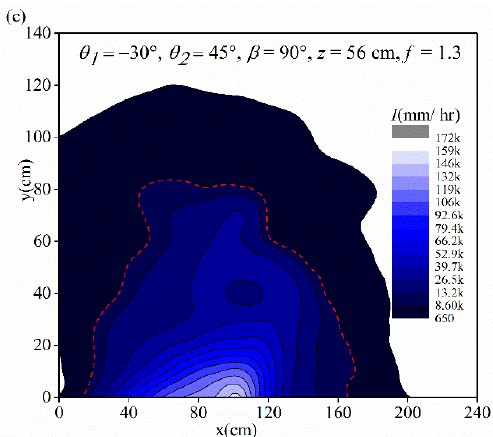
Figure 5. Rainfall intensity distribution at different collision angles on the x - o - y measuring platform.